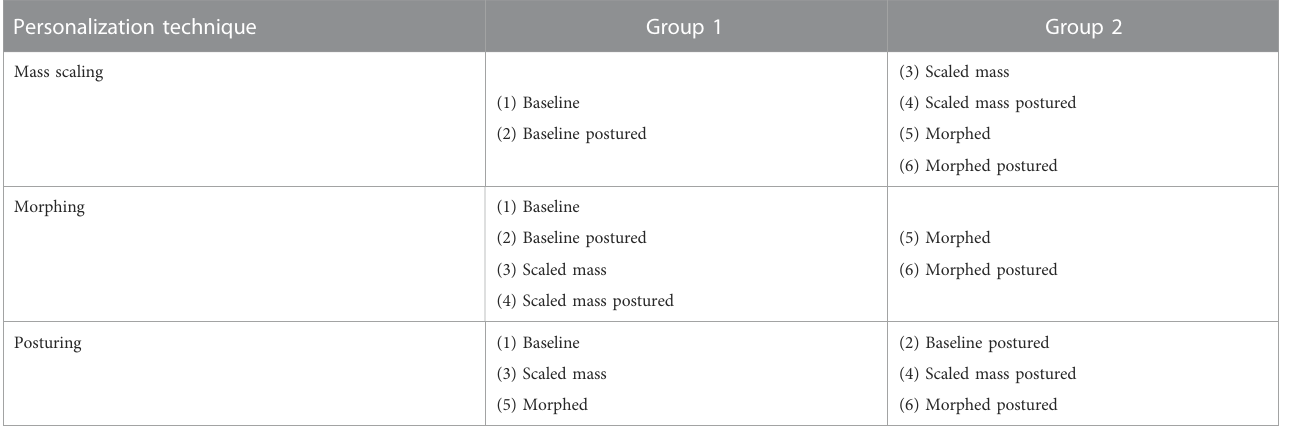
TABLE 5 Model versions groups for the analysis of the in fl uence of the three personalization techniques. Personalization technique